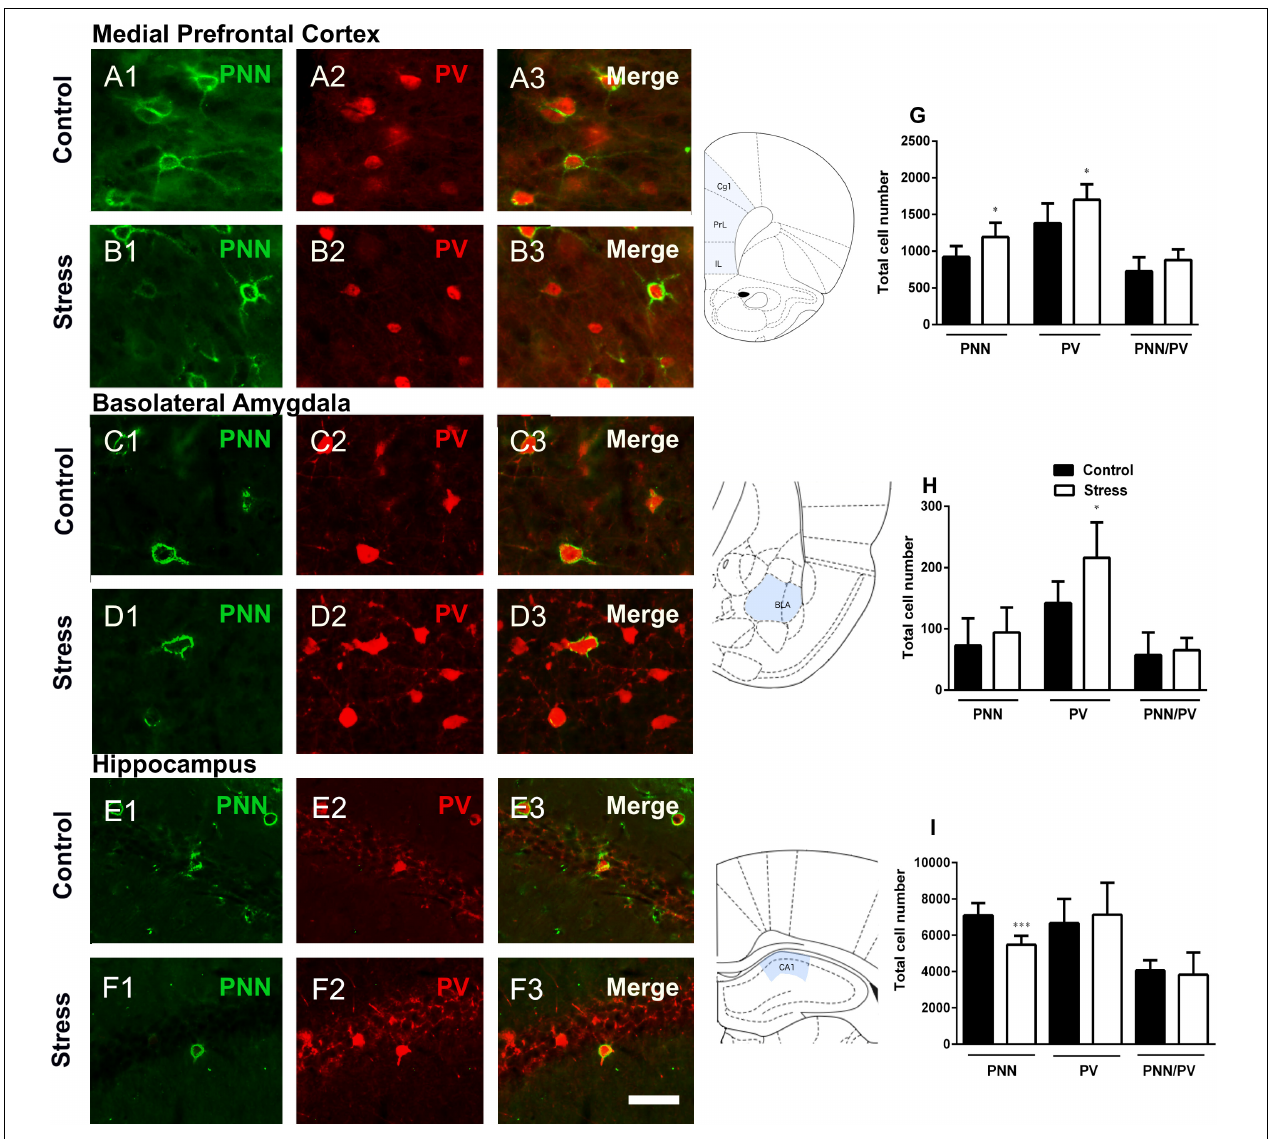
FIGURE 2 | Perineuronal nets (PNN), parvalbumin (PV) expressing neurons and their colocalization in the mPFC, basolateral amygdala and the hippocampal CA1 in control rats and after 10 days of chronic restraint stress. Representative confocal images showing the distribution of PNN ( A1–F1 ; green), PV + somata ( A2–F2 ; red) and their colocalization (A3–F3) in the mPFC (A,B) the basolateral amygdala (C,D) and the CA1 region of the hippocampus. Schemes on the right of figures (A–F) indicate the studied regions in light blue (modified from Paxinos and Watson, 1998). Graphs on the right side of the figure indicate changes in the total number of PNN, PV + somata and PV + somata surrounded by PNN in the mPFC (G) , the basolateral amygdala (H) and the hippocampus (I) . Values represent mean ± S.E.M. Asterisks indicate statistically significant differences between groups (Control × Stress) after unpaired Student’s t -test ( ∗ p < 0.05, ∗∗∗ p < 0.001). PrL: prelimbic cortex, IL: infralimbic cortex, Cg1: cingulate 1 cortex, BLA: basolateral amygdala. Scale bar 15 µ m.